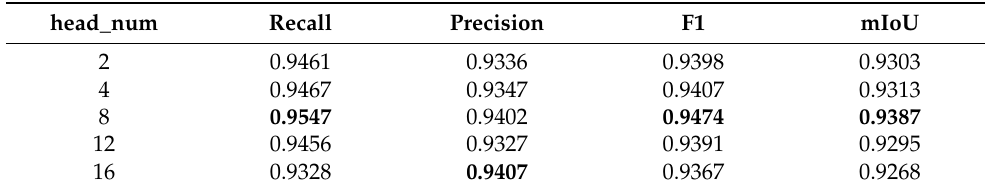
Table 10. Building extraction accuracies under different head_num settings when layer_num = 12. The highest accuracy is displayed in